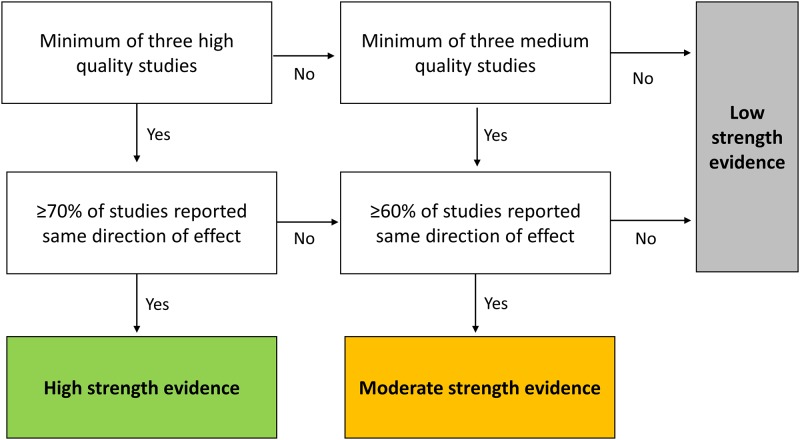
Algorithm for evaluating overall strength of evidence for each combination of SEP exposure and outcome, based on quality, quantity, and consistency of the evidence [54].High-quality studies were those that had controlled for age and sex in a multivariable analysis and had an NOS score of ≥7. Medium quality was assigned to studies that had controlled for age and/or sex in a multivariable analysis and had an NOS score of ≥5, or had not carried out multivariable analysis but had an NOS score of ≥6. Low-quality studies had no multivariable analysis and an NOS score of ≤5, or an NOS score of ≤4. High-strength evidence required ≥70% agreement about the direction of the exposure outcome association; moderate strength evidence required ≥60% agreement. NOS, Newcastle-Ottawa Quality Assessment Scale; SEP, socioeconomic position.